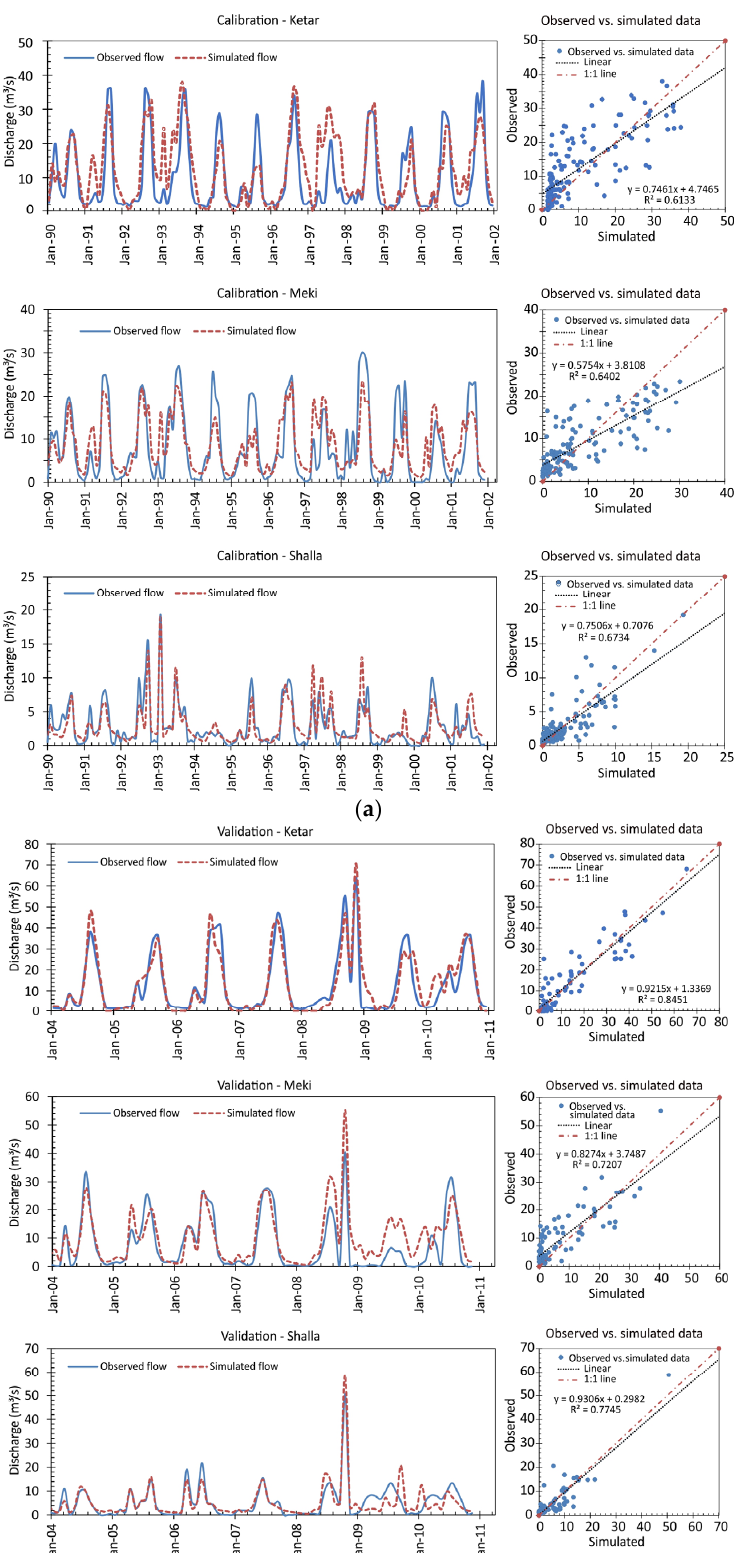
Figure 4. Calibration ( a ) and validation ( b ) results of the models for the CRV sub-basins.